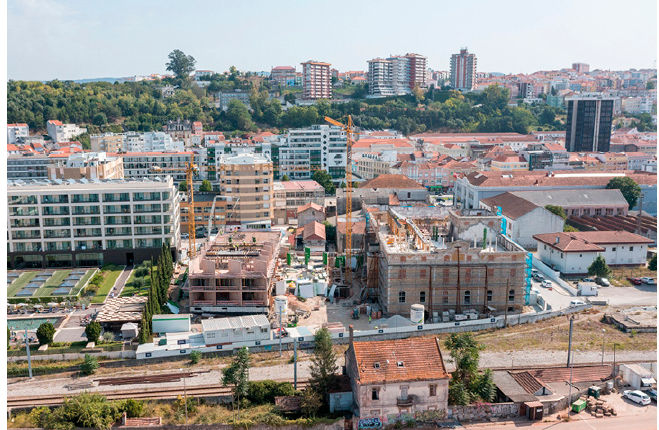
Figure 7. Coimbra. Aerial view.